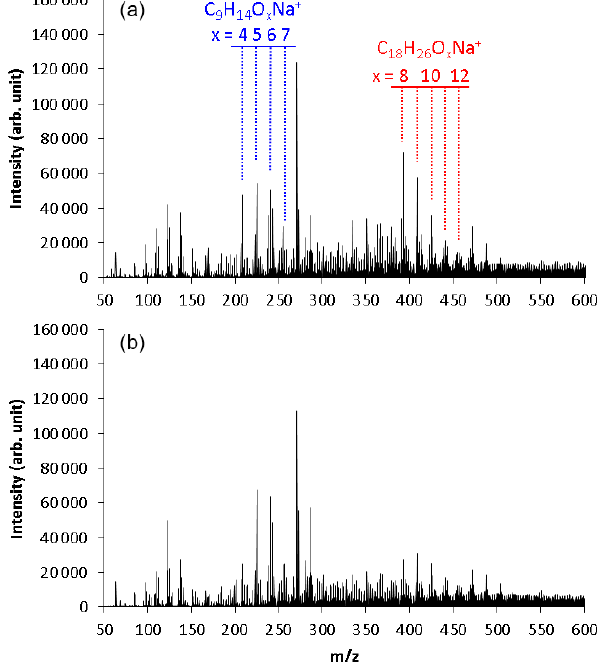
Figure 2. Mass spectra observed using positive-mode electrospray ionization time-of-flight mass spectrometry for TMB SOA samples collected in (a) normal photooxidation (run 1) and (b) aging exper- iments (run 2). These results were obtained by direct infusion of the SOA samples to the ESI mass